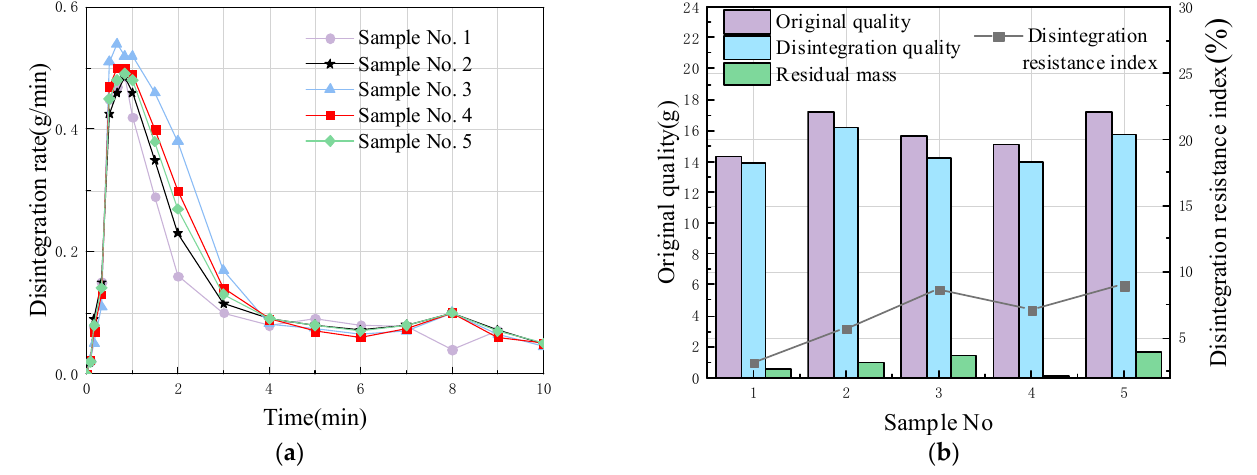
Figure 5. Test results of sample disintegration characteristics (average mass of 15.88 g): ( a ) comparison of sample disintegration rates; and ( b ) comparison of sample resistances to disintegration index.